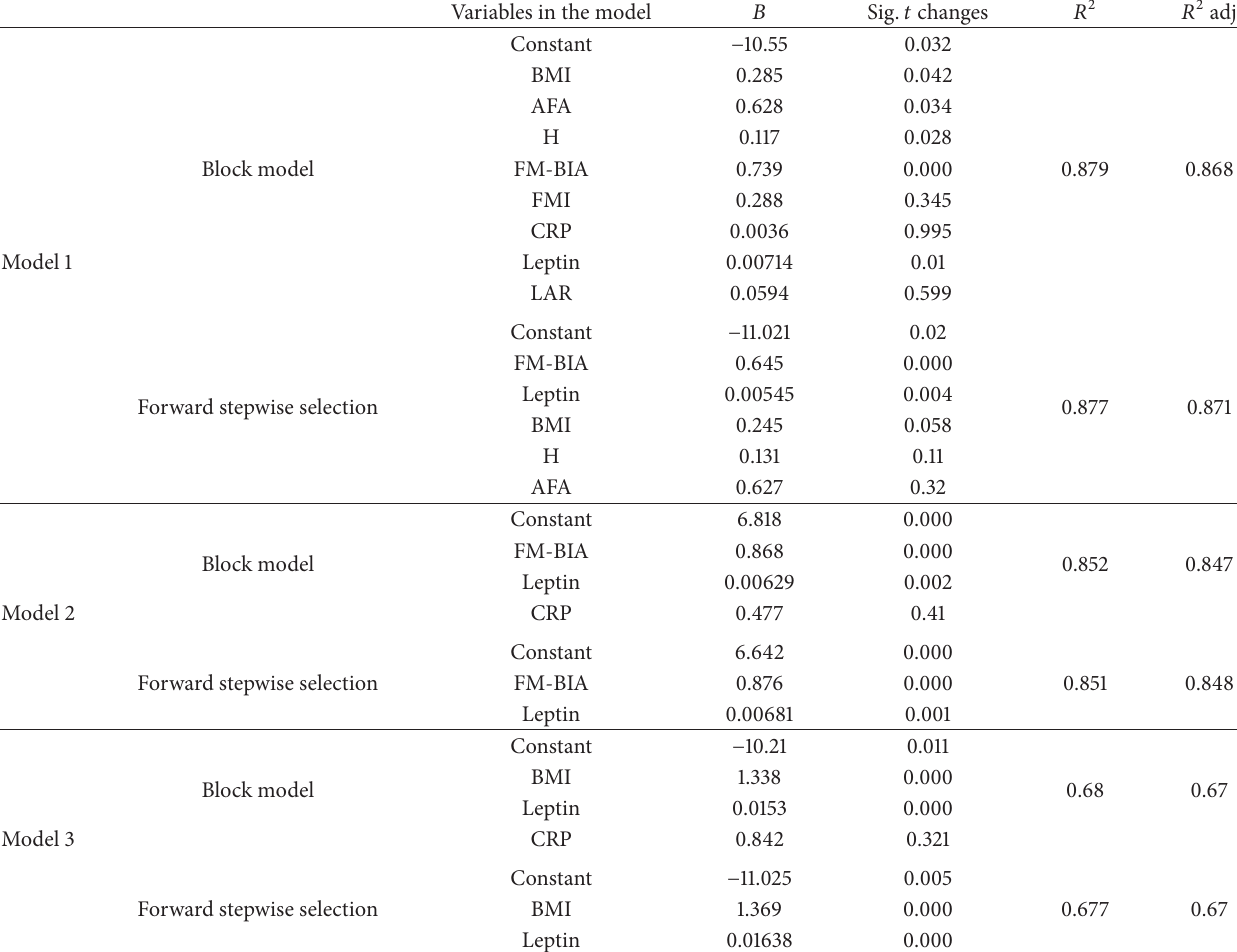
Table 4: Fat mass prediction (FM from DXA)—multivariate regression